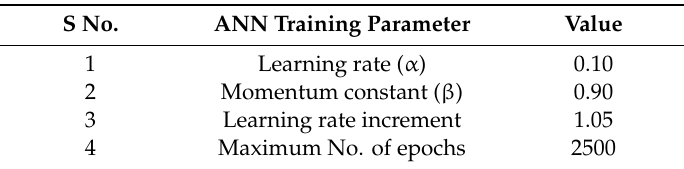
Table 2. ANN training parameters.